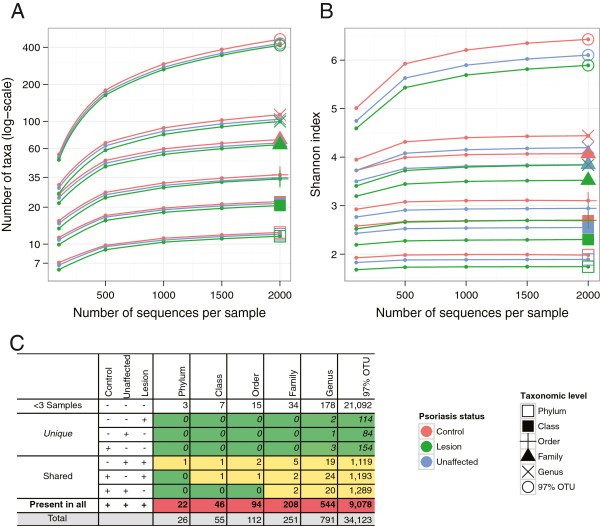
α Diversity rarefaction curves of cutaneous microbiota in psoriasis (lesion), unaffected and control specimens. (A) Taxonomical richness trends towards decreasing α diversity in unaffected and lesion specimens relative to control, with no statistically significant differences between skin types. (B) Shannon index is significantly different (decreases from control to unaffected to lesion) among skin types at all taxonomic levels (P <0.05), except at the operational taxonomical unit (OTU) level. (C) Analysis of taxa sharing. Taxa present in <3 samples excluded from the analysis. Taxa that are only observed in one clinical skin type are denoted as ‘unique’. Taxa that are present in two types of skin are denoted as ‘shared’. The data show that nearly all taxa are represented in all three types of skin. The shading represents the relative distribution (heatmap) for each column number (green = low, yellow = intermediate, red = high).